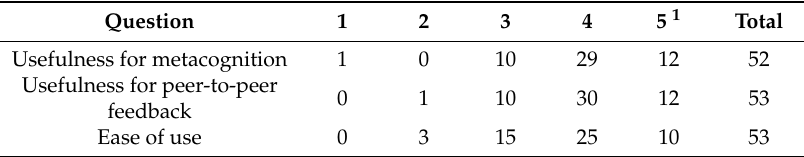
Table 3. Descriptive statistics about usefulness and usability of the tool (N = 53).